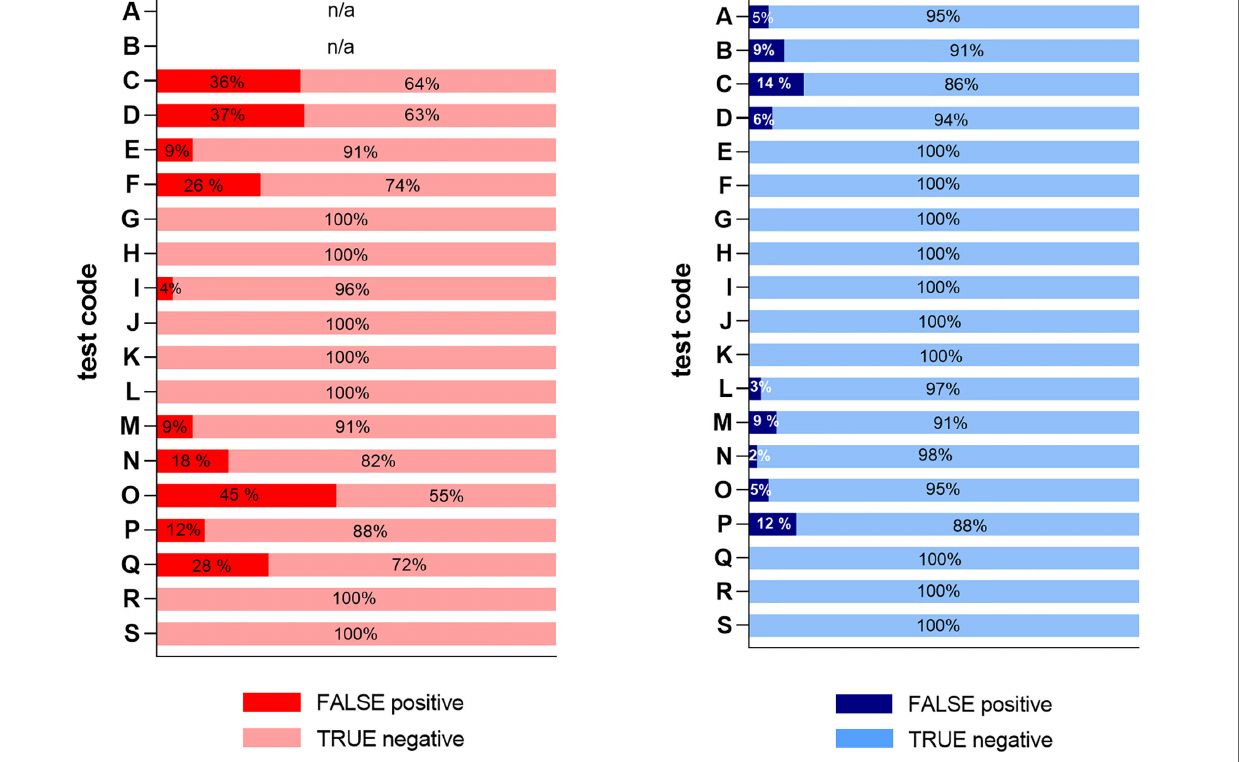
FIGURE 1 | Overview of false positive results in all samples for 19 different serological tests. Six LFA tests (G, H, J, K, R & S) gave no false positive results. The false positivity rate of the remaining tests ranged between 2 - 45%. The test code keys are described in Table 2 . The two ELISA assays (test A and B) were only tested for